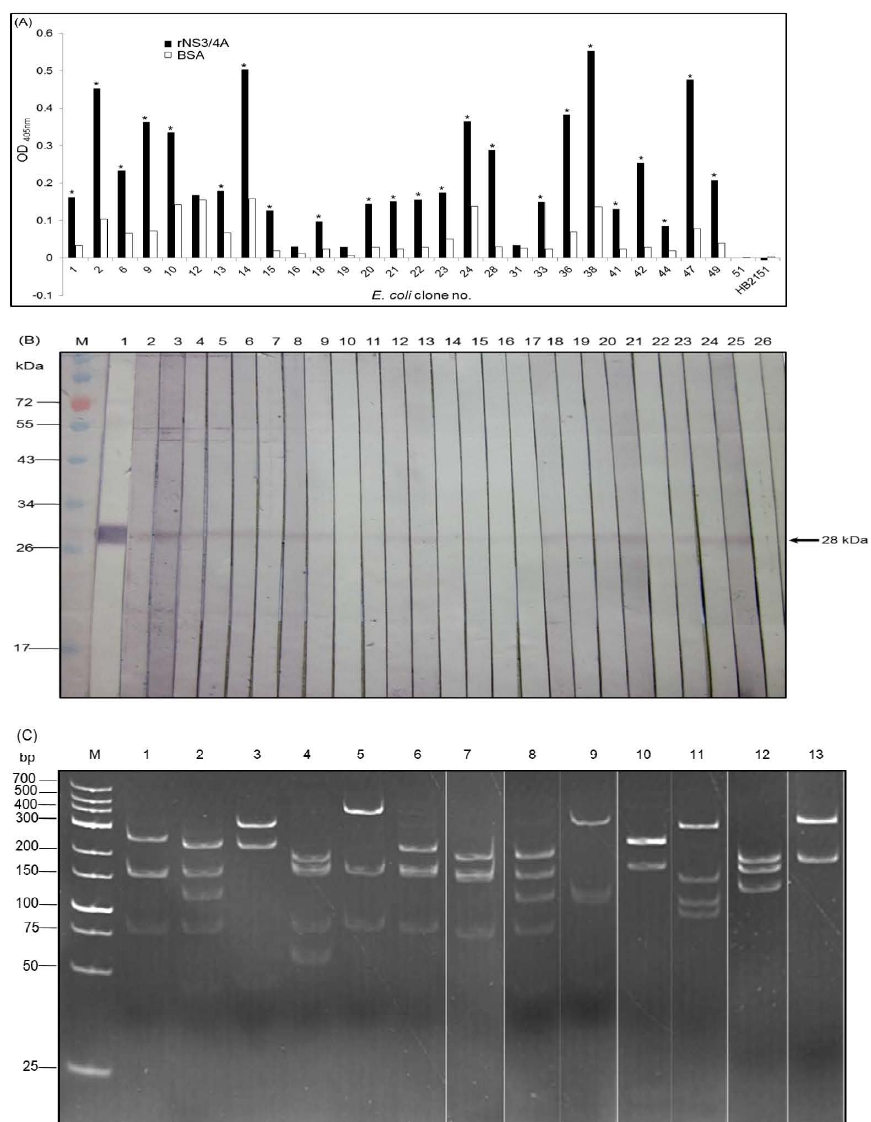
Figure 3. Binding of the VHs/V H Hs expressed from the 28 vh/v h h- positive E. coli clones to the rNS3/4A and restriction fragment length polymorphism (RFLP) of the vhs/v h hs of the antigen specific nanobodies. ( A ) Indirect ELISA results. Nanobodies from 23 of the 28 E. coli clones gave significant OD 405nm ELISA signal to the rNS3/4A above the control antigen (BSA). They were clone nos. 1, 2, 6, 9, 10, 13–15, 18, 20–24, 28, 33, 36, 38, 41, 42, 44, 47 and 49. Normal E. coli lysate (HB2151) was used as the background control; ( B ) Western blotting results. The VHs/V H Hs of the 23 clones also bound specifically the SDS-PAGE separated-rNS3/4A(lanes 2–24). Lane M, Protein molecular mass marker. Lane 1, SDS-PAGE separated-rNS3/4A probed with mouse anti-6× His tag which served as positive control; ( C ) DNA banding patterns (RFLP) of vhs/v h hs from the 23 E. coli clones which revealed 13 different patterns. Lane 1, pattern 1 (clone no. 1); lane 2, pattern 2 of clone nos. 2, 14, 22 and 44; lane 3, pattern 3 of clone nos. 6, 21 and 36; lane 4, pattern 4 of clone no. 9; lane 5, pattern 5 of clone nos. 10, 28 and 49; lane 6, pattern 6 of clone nos. 13 and 47; lane 7, pattern 7 of clone no. 15; lanes 8–13, pattern 8–13 of clone nos. 18, 20, 24, 28, 33 and 41, respectively. Lane M, GeneRuler TM 1 kb DNA